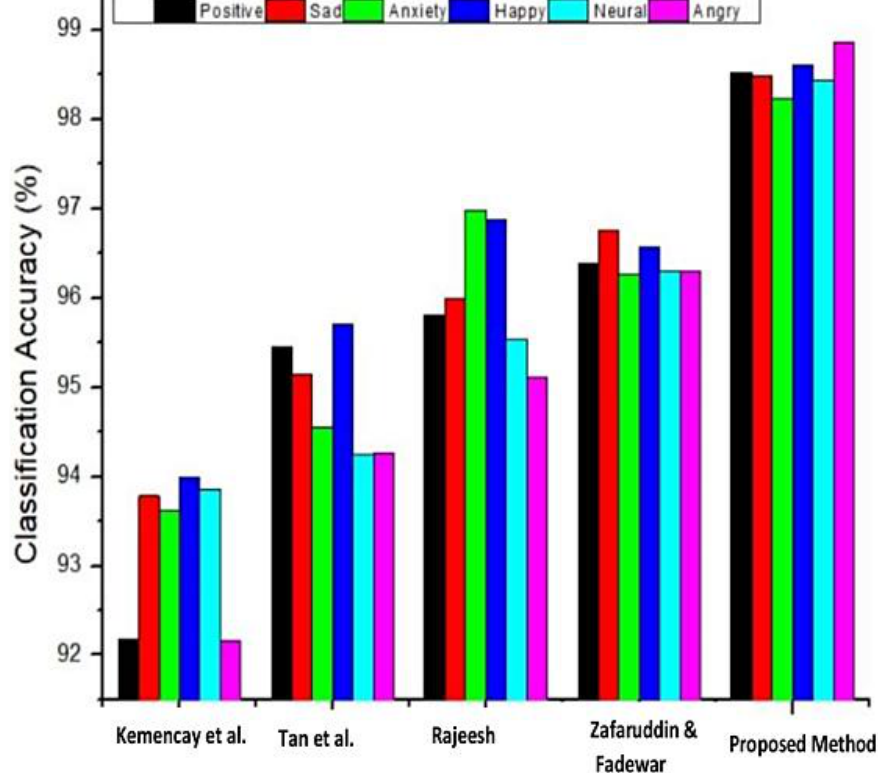
Figure 15. Classification accuracy analysis for different emotions based on the OLR dataset [7,30 – 32].